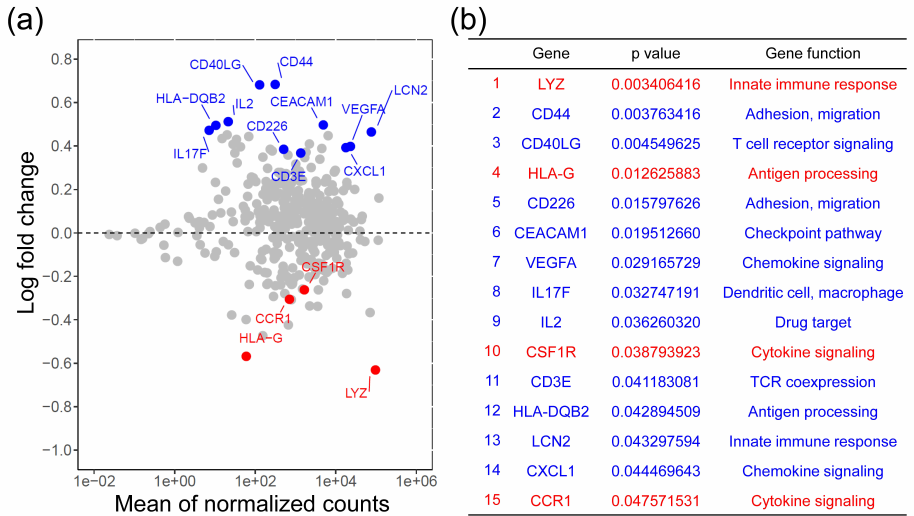
Figure 2. Immune response genes differentially expressed in CRCs with CSF1R c.1085 genotype A_A and A_G. ( a ) The MA-plot showing log-fold change against the average of expression levels for each gene between CRCs with CSF1R c.1085 genotype A_A and A_G. The x -axis indicates the mean of normalized reads for each gene and the y -axis indicates the log 2 fold of change. The red and blue dots represent the fact that the genes had a significantly higher expression level in the groups of genotype A_A and A_G, respectively. ( b ) The list of genes differentially expressed in the groups of CSF1R c.1085 genotype A_A and A_G with statistical